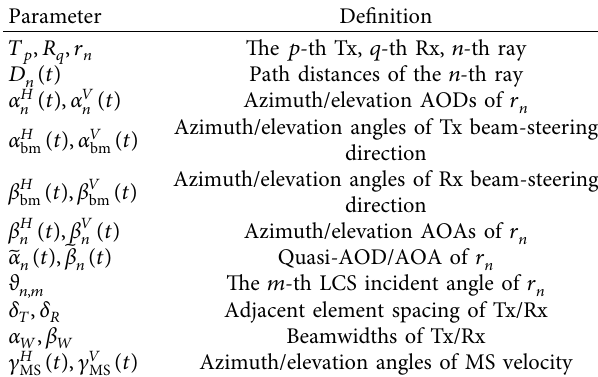
Table 2: Important parameter